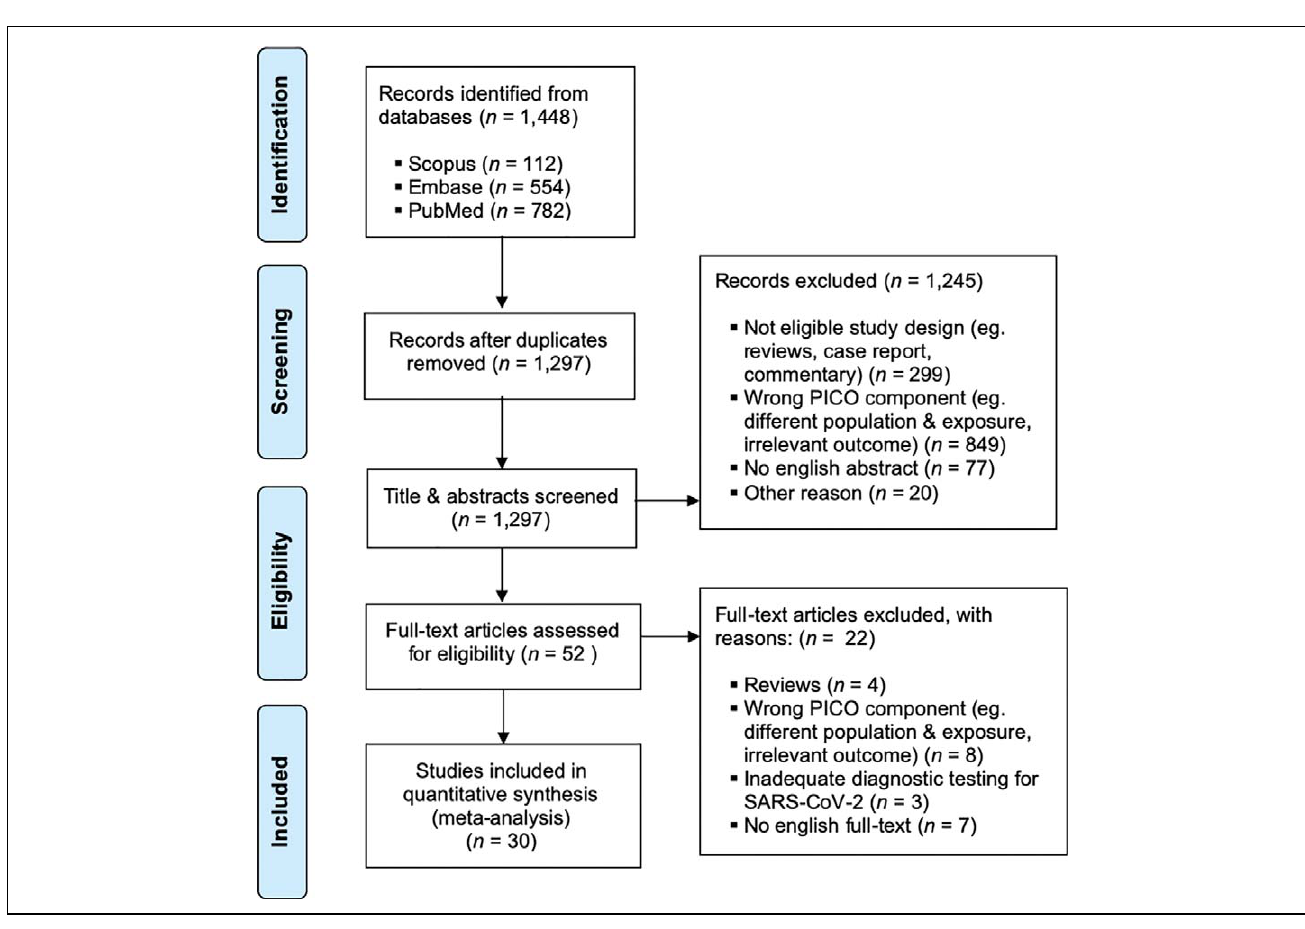
Figure 1. PRISMA flow